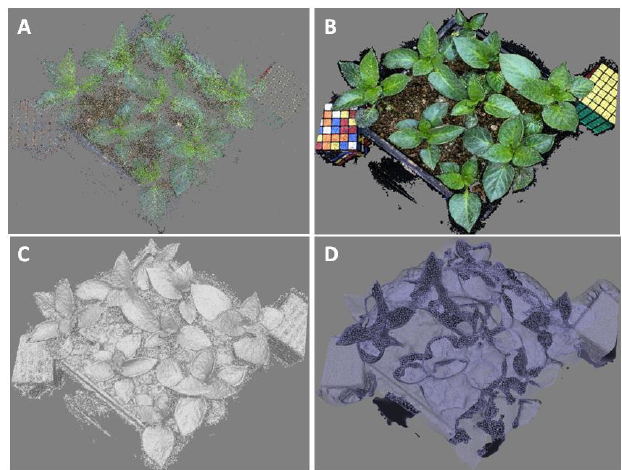
Figure 4. Procedure of 3D modeling for paprika plants reconstructed from a series of photos taken by